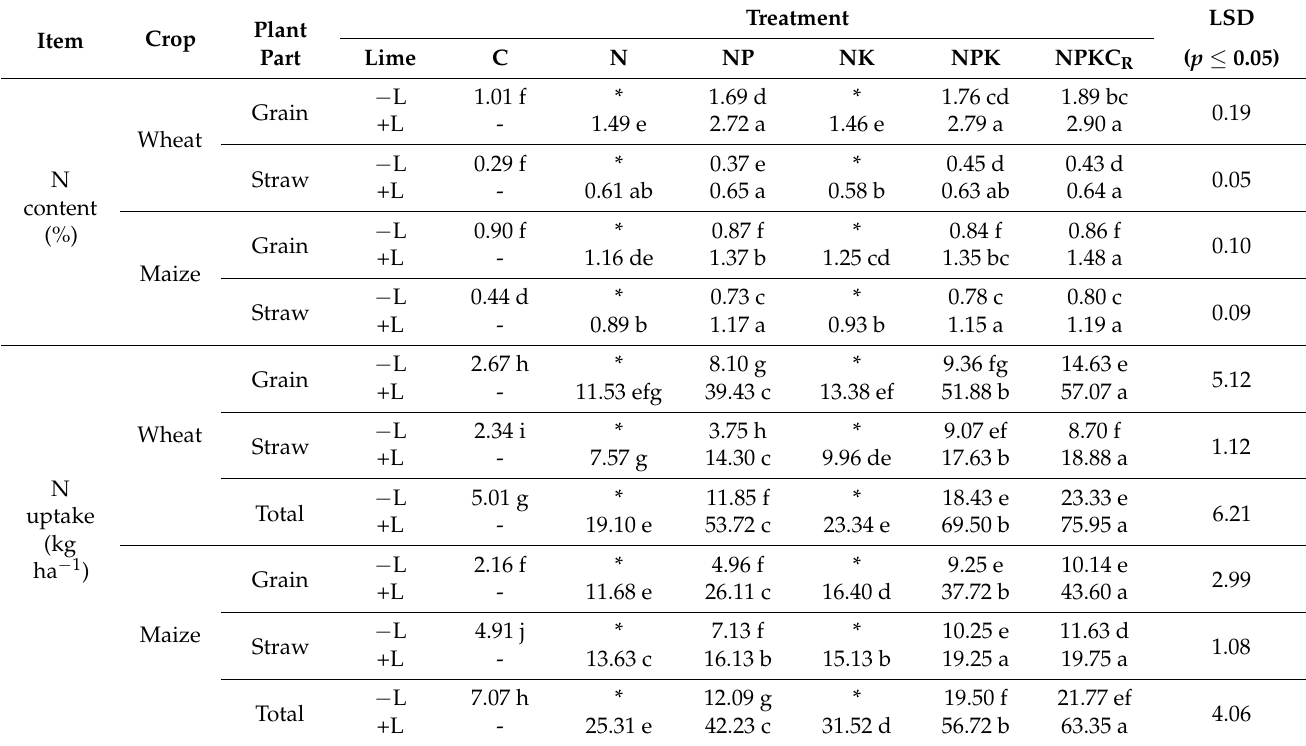
Maize Means followed by different letters within the same row are significantly different from each other at p ≤ 0.05 by LSD test with ns denoting p > 0.05. C: no fertilizer application or control, N: nitrogen, NP: N and phosphorus (P), NK: N and potassium (K), NPK: N, P, and K, NPKC R : NPK plus crop residue (C R ). Table 4. Average N content and uptake at maturity in response to different fertilization treatments after liming (over